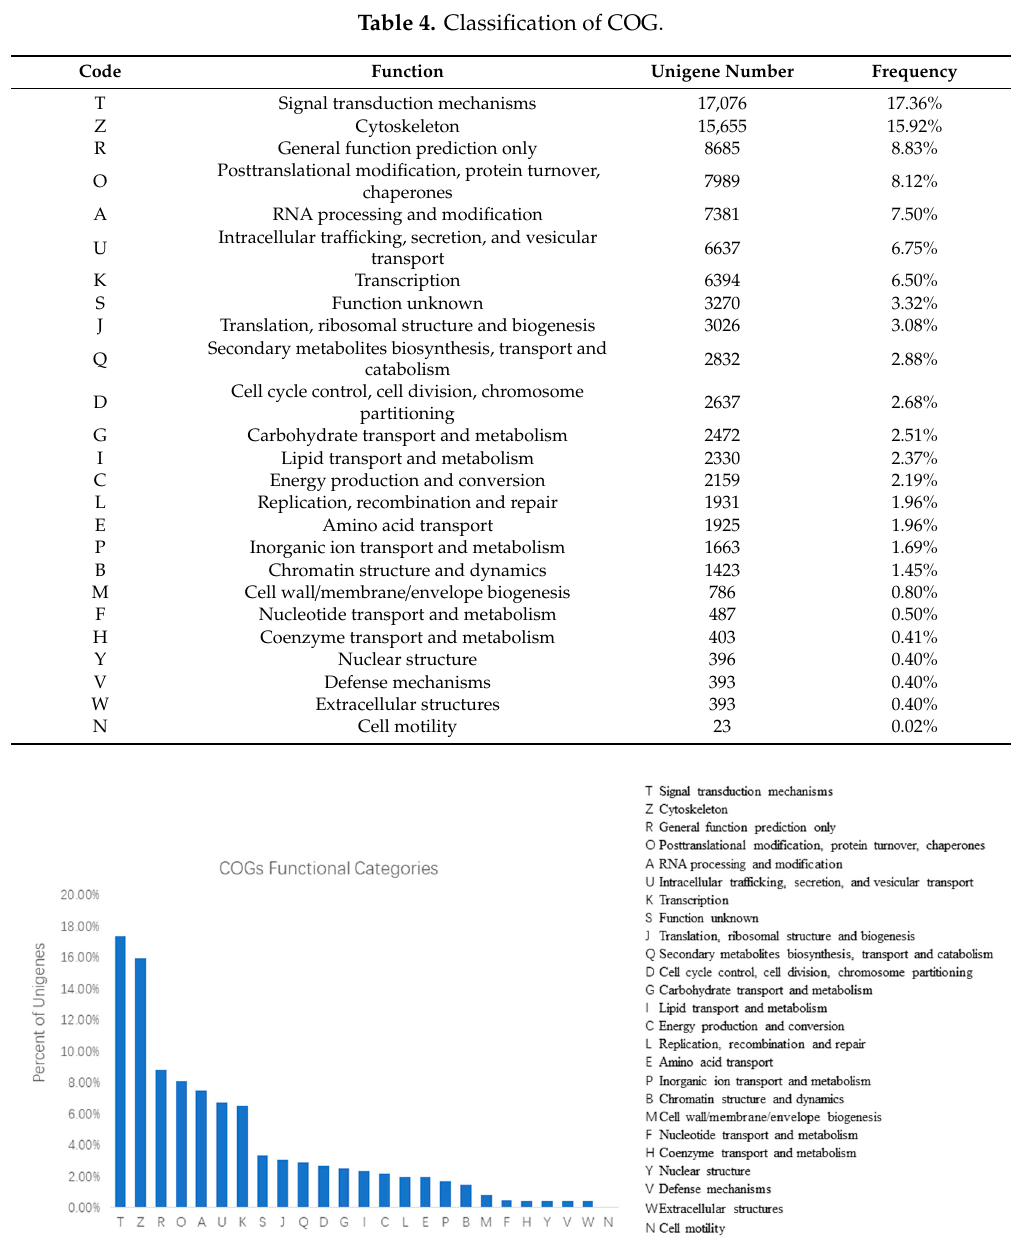
Figure 4. Clusters of orthologous groups (COG) classifications. Table 4. Classification of COG